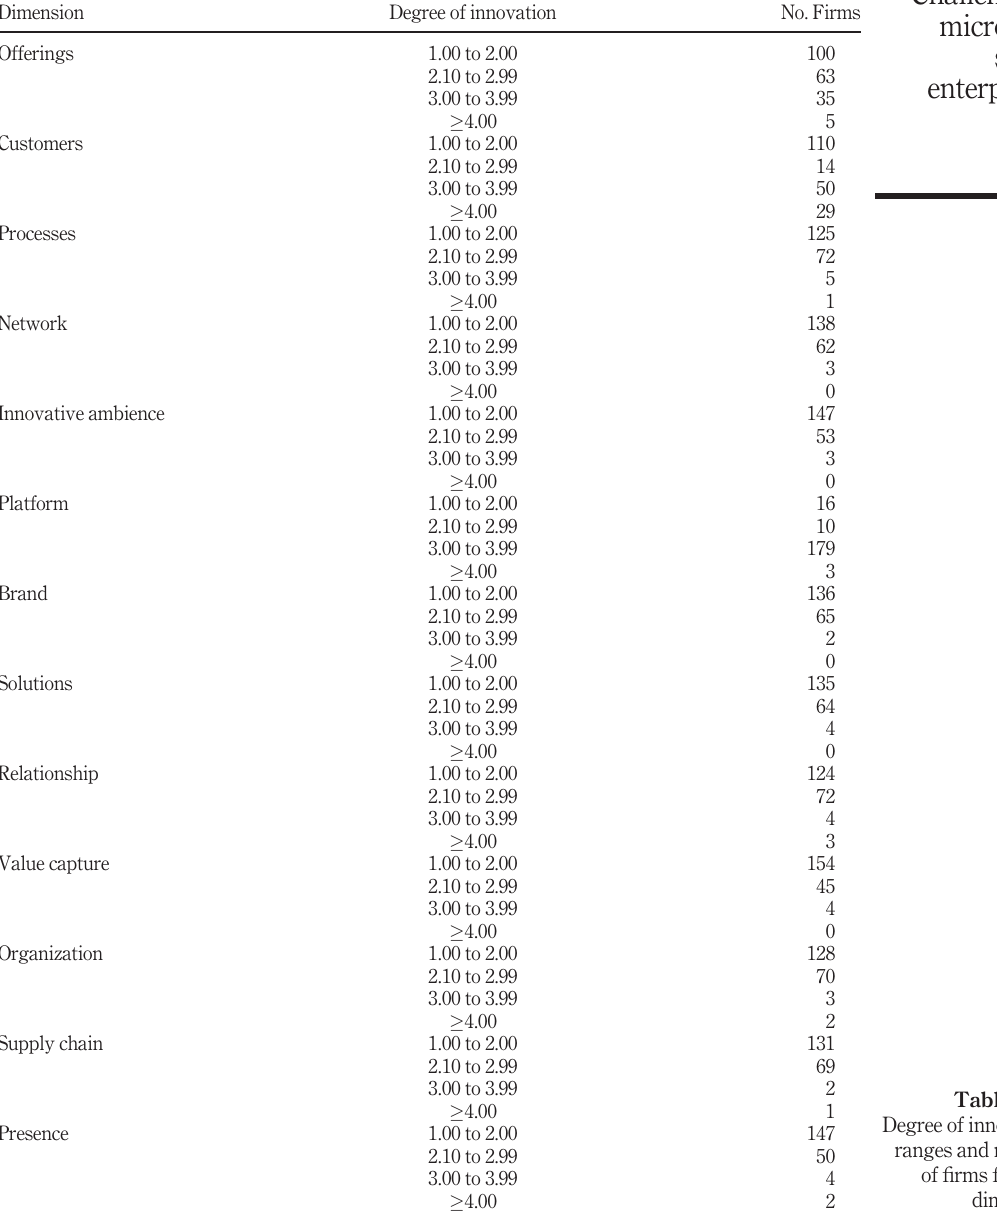
Table VIII. Degree of innovation ranges and number of fi rms for each